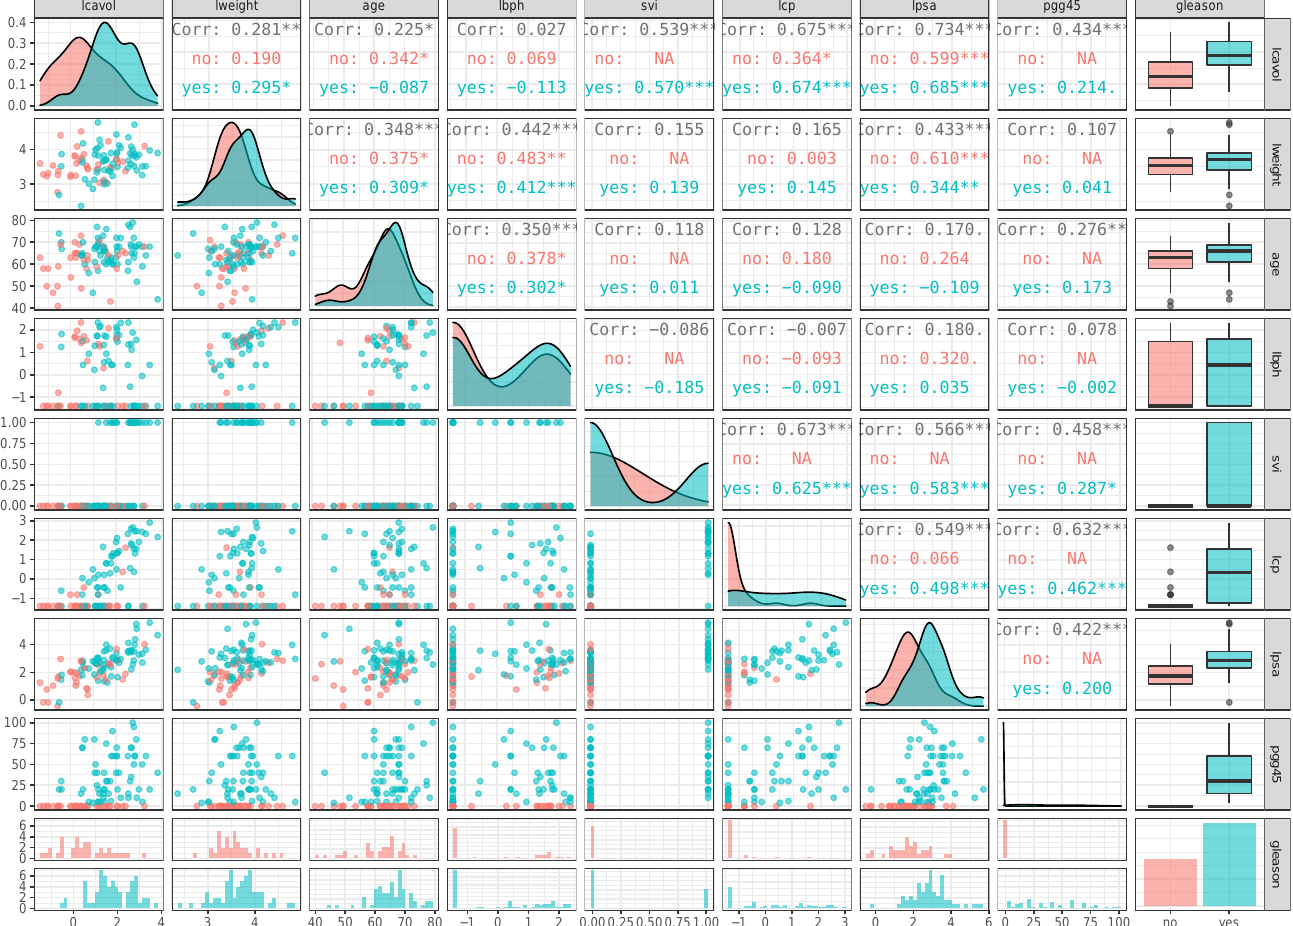
Figure 6. Scatter plot and correlation between variables by response in prostate cancer